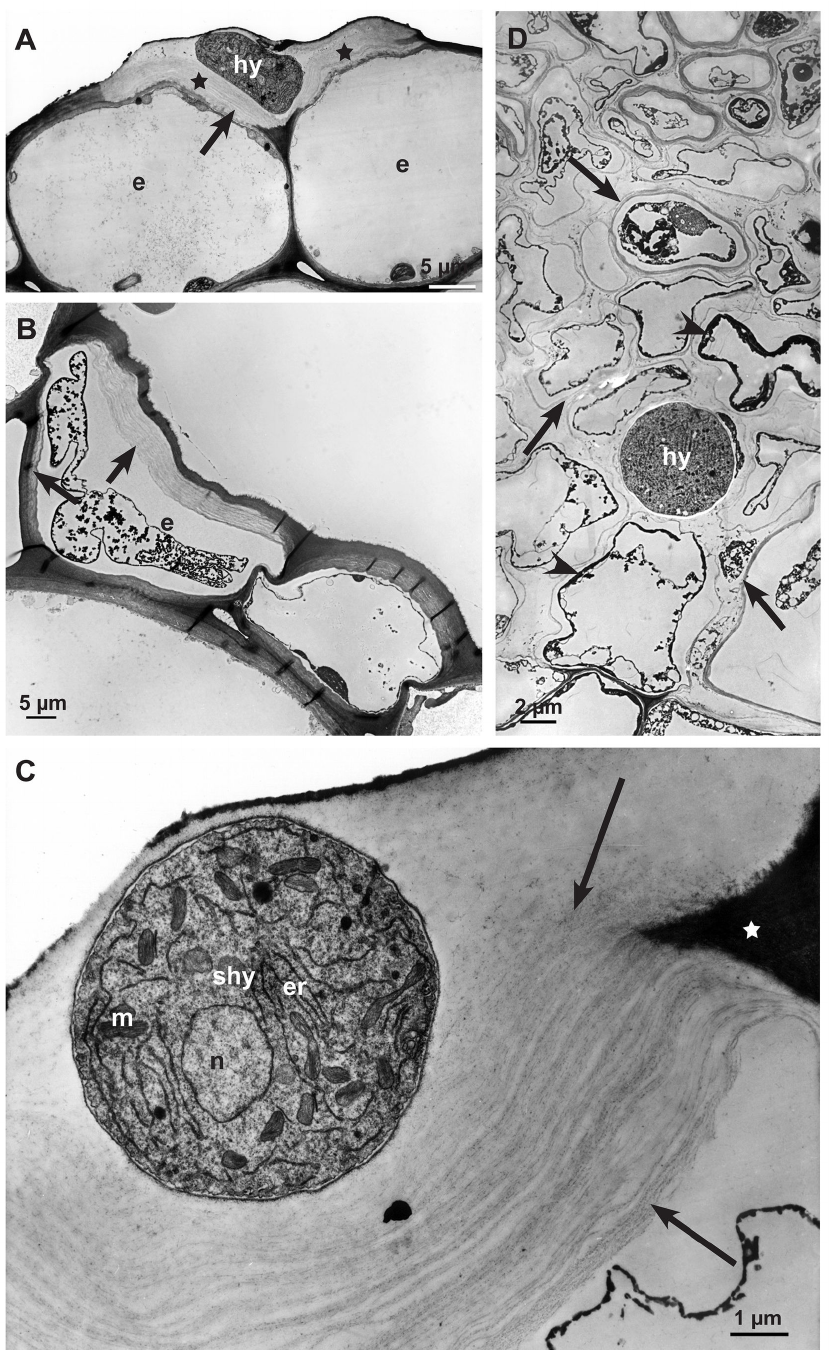
Figure 4. Degradation process of the cell wall matrix in early (12-24 hpi) and advanced (36-48 hpi) infection stages. Transmission electron micrographs of cross sections of sunflower hypocotyls: A : The abaxial epidermal cell wall around a subcuticular hypha (shy) 12-24 hpi showing degraded cell wall matrix (stars). Cytoplasm of the epidermal cells (e) still intact. B : Destruction process of cell wall in dead host cells starting from the inner side of the cell wall (arrows) of an epidermal cell (e) 12-24 hpi. C : Detail of a degraded abaxial epidermal cell wall around a subcuticular hypha (shy); non-degraded part of the plant cell wall (star), cell wall matrix degraded, residues of cellulose layers (arrows), nucleus (n), endoplasmic reticulum (er) and mitochondrium (m) of the fungal cell. D : During the advanced infection stage (36-48 hpi) a single hypha (hy) in a large area of the necrotic cortical parenchyma. Only residues of thin cell wall layers (arrows) and dark staining residues of cytoplasm are left (arrowheads). doi: 10.1371/journal.pone.0072292.g004 PLOS ONE | www.plosone.org 5 August 2013 | Volume 8 | Issue 8 |